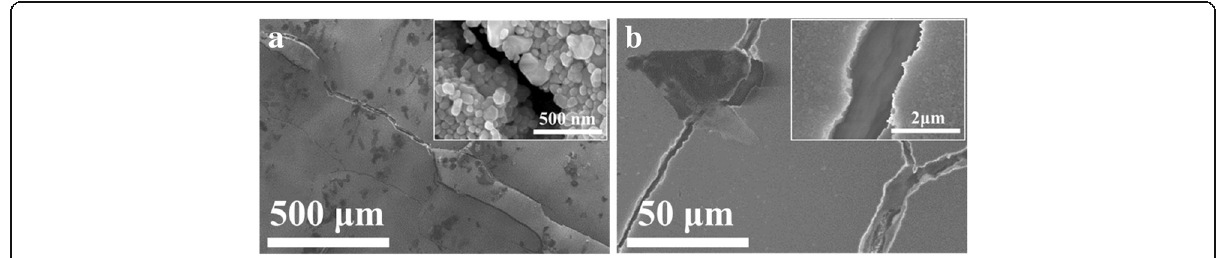
Fig. 9 SEM images of the silver electrodes on photopaper with bending radii of 0.5 mm in different cycles. a 10 cycles. b 100